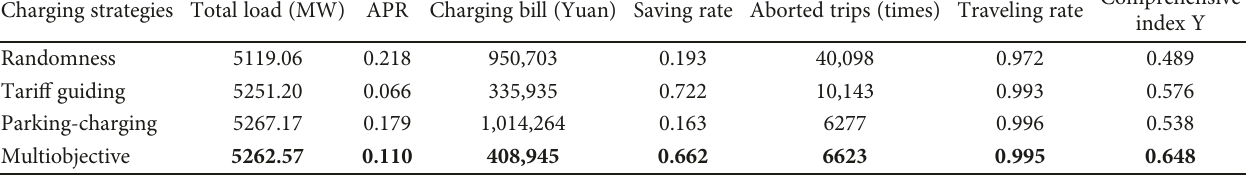
Table 7: The index comparison of di ff erent charging strategies during daily